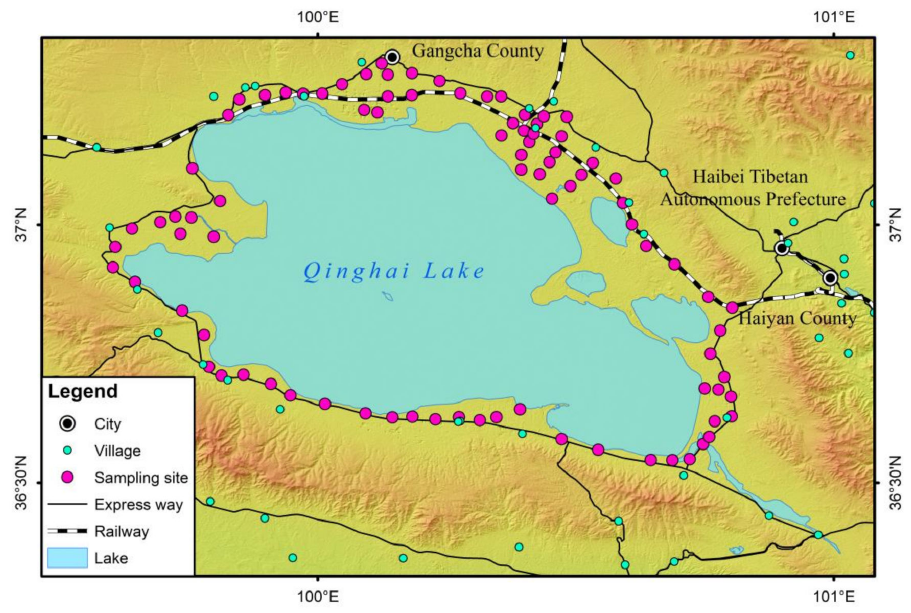
Figure 1. Distribution of the soil sampling sites around Qinghai